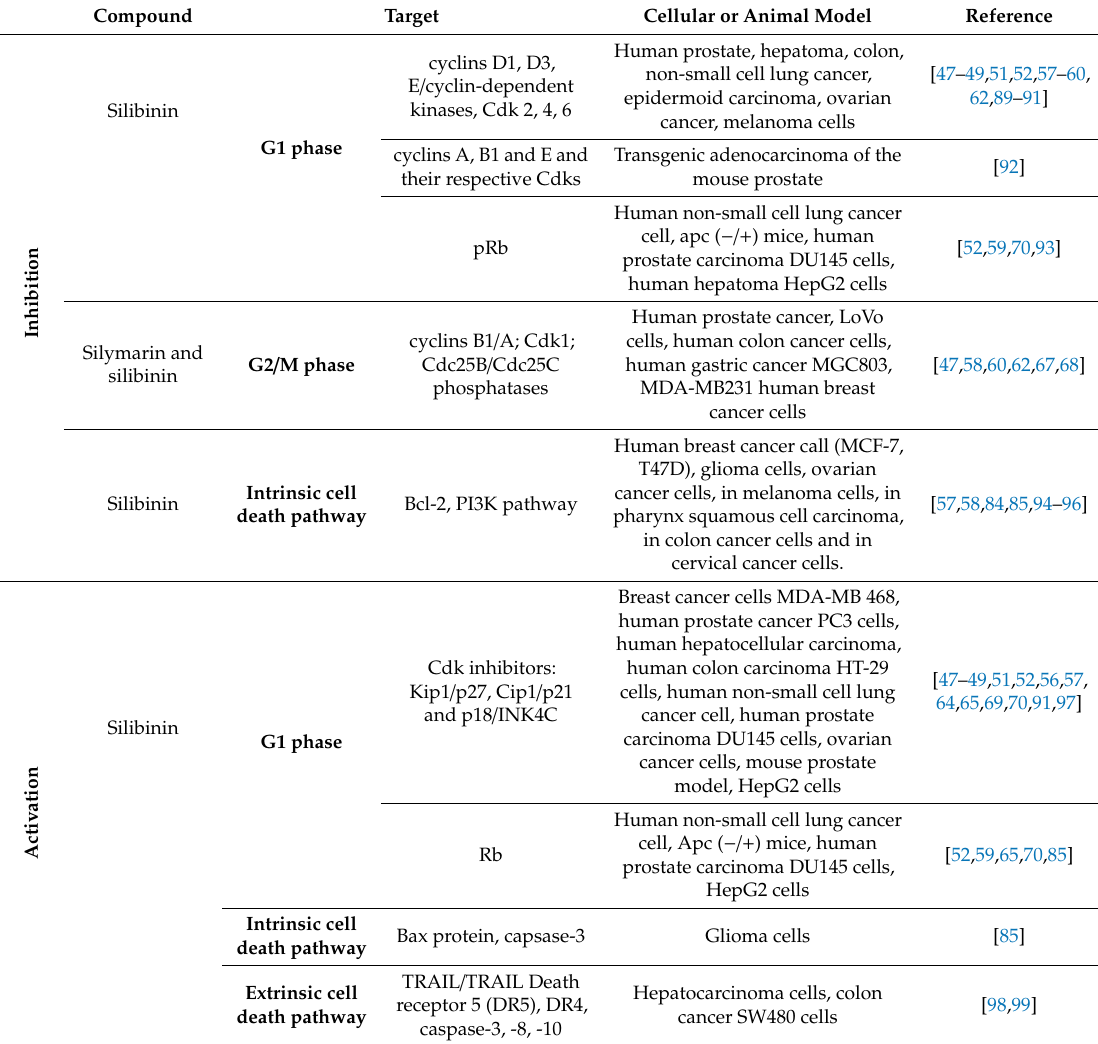
Table 2. Targets in cellular and animal models of Milk Thistle’s Active Components used alone: cell cycle, extrinsic and intrinsic cell death